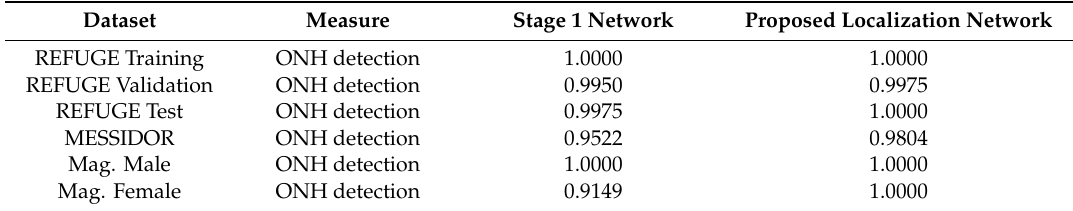
Table 3. Localization network accuracy results.